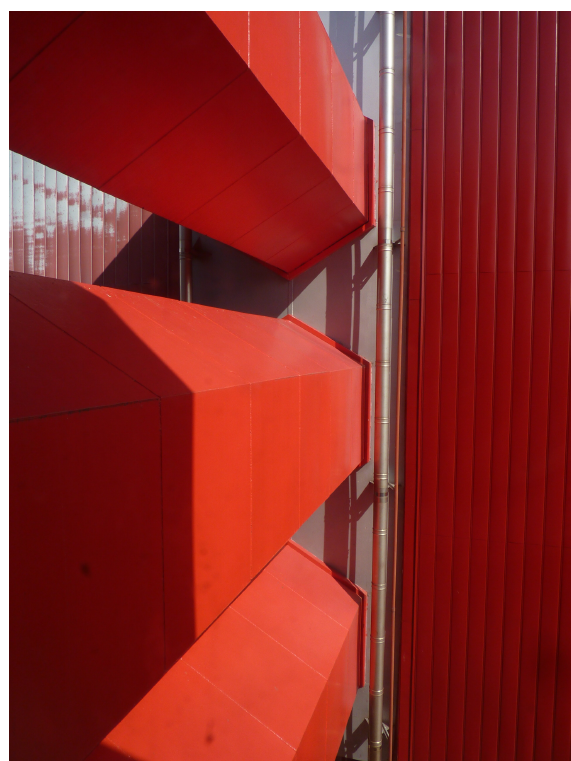
Figure 5. Telecommunications building in Hradec Králové in